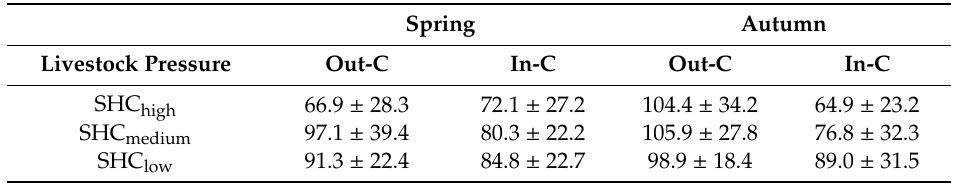
Table A4. Average QBS-ar values ± SD found at each SHC (high, medium and low livestock pressure), in each Location (beneath = in-C and outside the canopy = out-C) during both sampling campaigns.